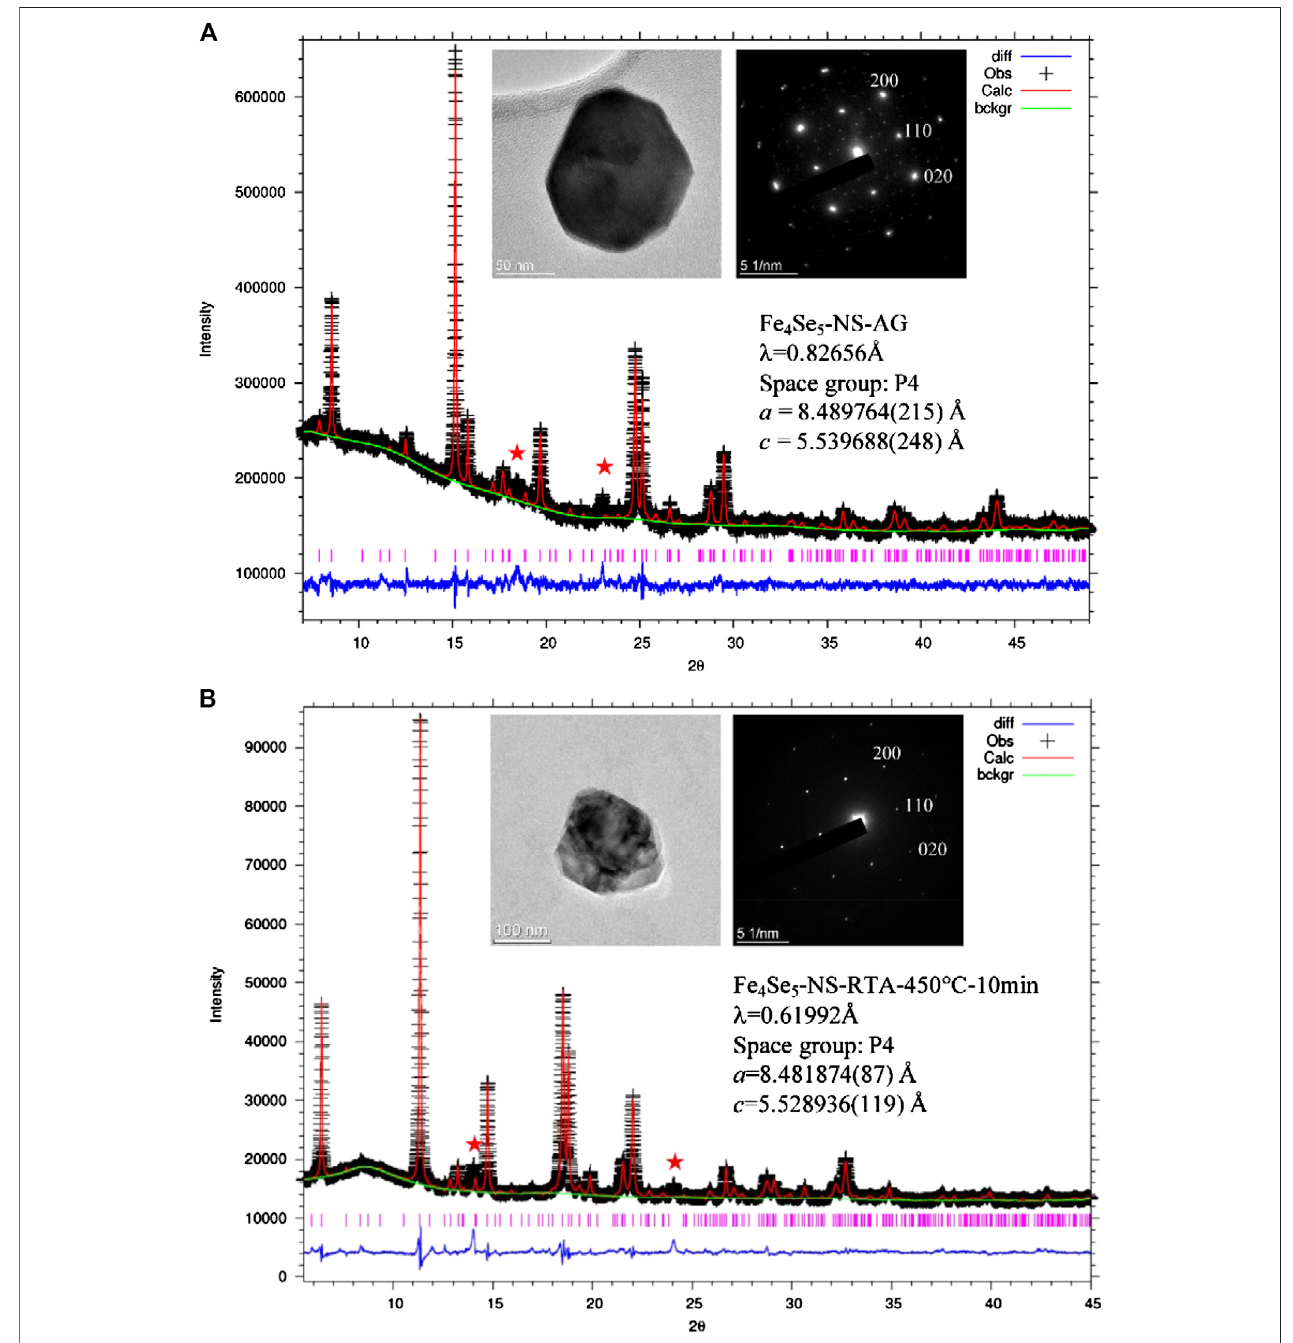
FIGURE 1 | X-ray diffraction patterns and their Rietveld re fi nement results of (A) the as-grown Fe 4 Se 5 nanocrystals and (B) the sample after the RTA process at 450 ° C. The insets in (A) and (B) show the transmission electron microscope (TEM) images and selective area electron diffraction (SAED) patterns of the samples,